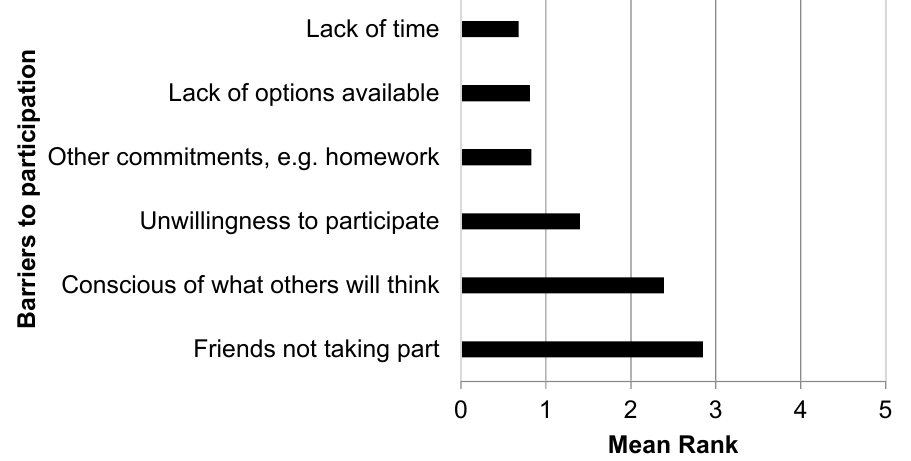
Figure 3. Perceived main barriers † to participation in extra-curricular physical activity from adolescent females (aged 11–14 years). † Responding schools asked to rank the main barriers from an adolescent females’ perspective from 1 to 6 (where 1 is the least and 6 is the greatest barrier).